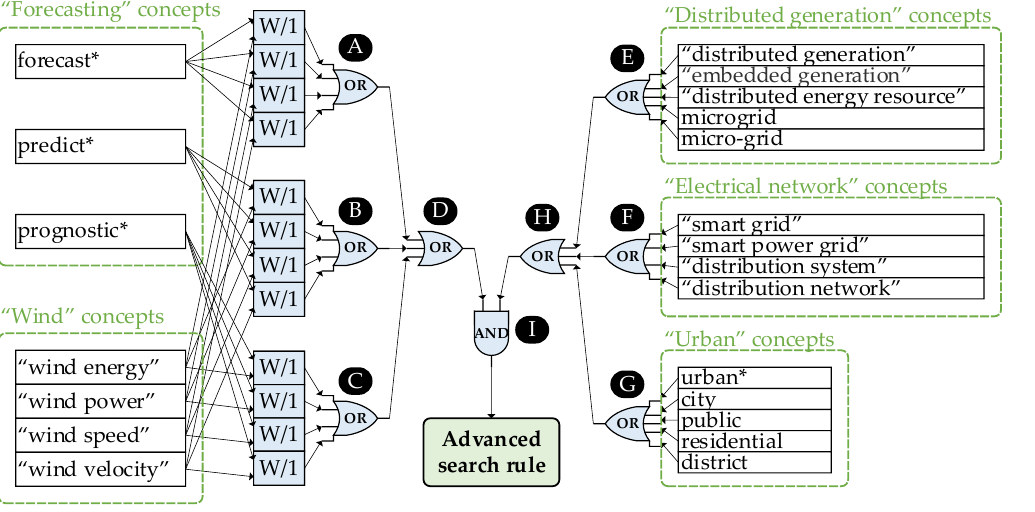
Figure 2. Advanced search rule.